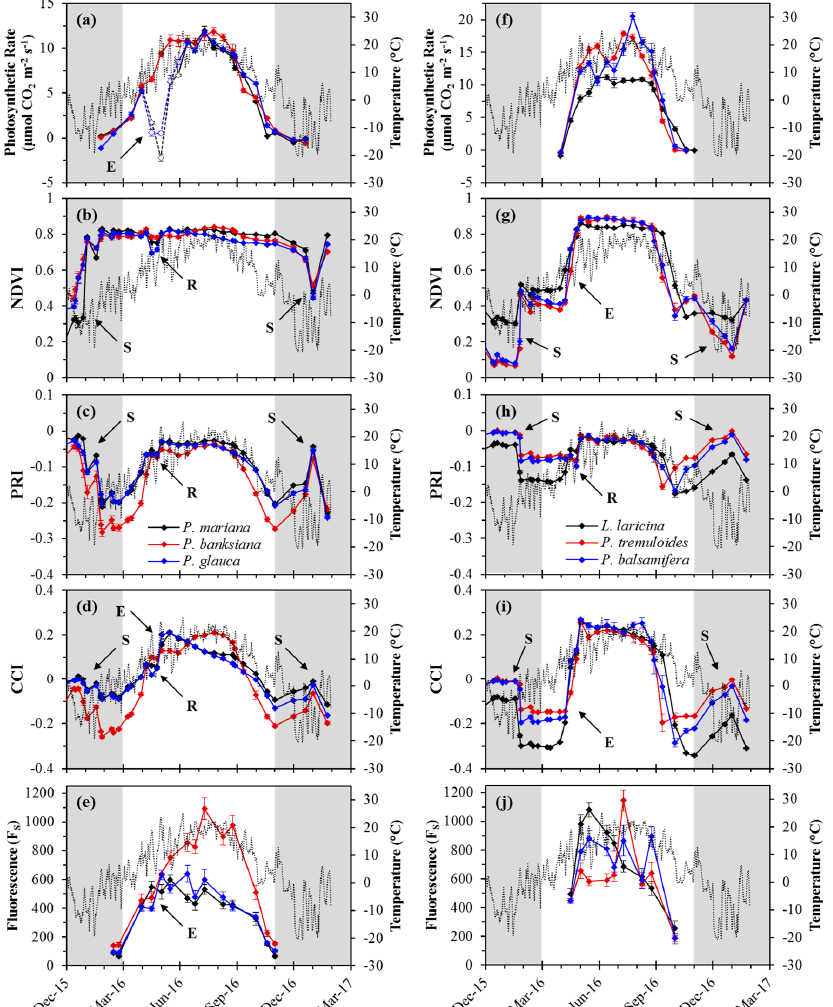
Figure 3 . Annual patterns of midday average temperature (grey line), optical indices and photosynthetic metrics for evergreen and deciduous species. Evergreen species ( a − e ) included P. mariana (black), P. banksiana (red), and P. glauca (blue). Deciduous species ( f − j ) included L. laricina (black), P. tremuloides (red), and P. balsamifera (blue). Optical indices ( b − d , g − i ) were calculated from reflectance measurements at the canopy-level. Fluorescence (F S ) was measured at the leaf-level. Data points shown were obtained near solar noon from December 2015 to January 2017. Open points ( a ) denote dates during the spring transition, where new branches were sampled for P. mariana and P. glauca . The winter period is indicated by the grey regions (November–March). Annotations on figures indicate the effects of snow (S), repotting (R), and new-leaf expansion (E). For deciduous trees, data were restricted to periods with fully formed leaves during the growing season. Error bars denote ±SE of the mean.